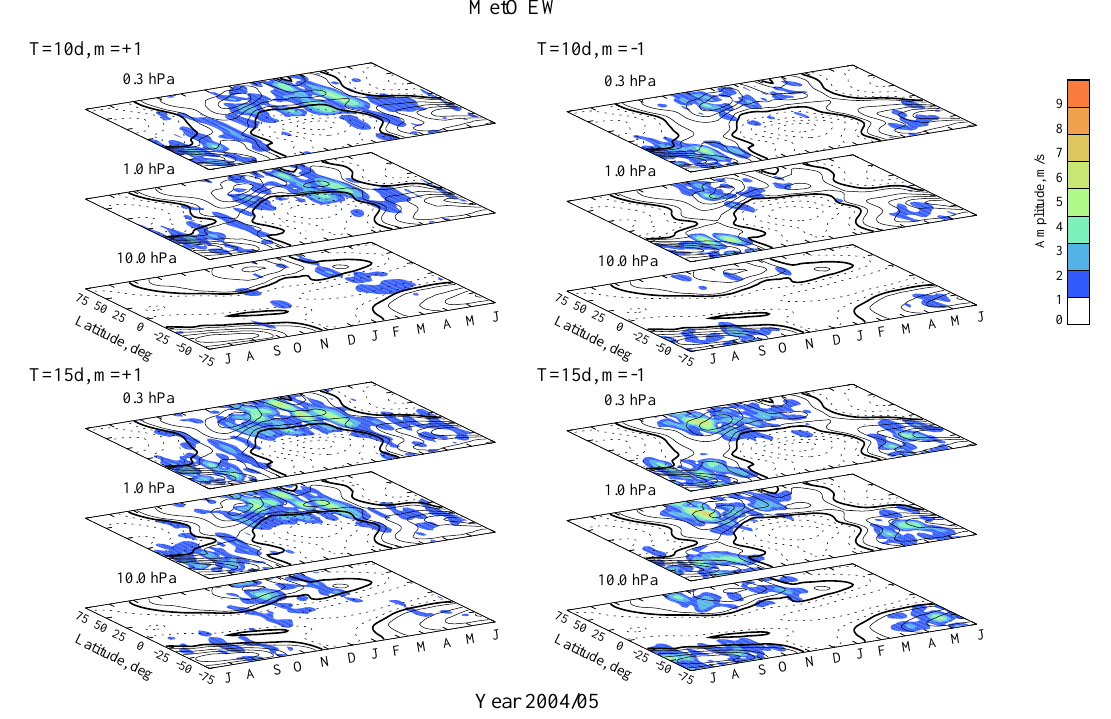
Fig. 3. The amplitudes of the MetO EW wind oscillations with periods 10 (the upper row) and 15 (the bottom row) days and west- ward/eastward wave numbers +/ − 1 versus latitude are shown for the time interval from July 2004 until June 2005. The mean zonal EW winds smoothed over 30 day intervals with 5 day step are contoured by solid (positive, eastward) and dashed (negative, westward) lines. The thick line is the “zero wind” line. The other contours are ... − 30, − 10, +10,